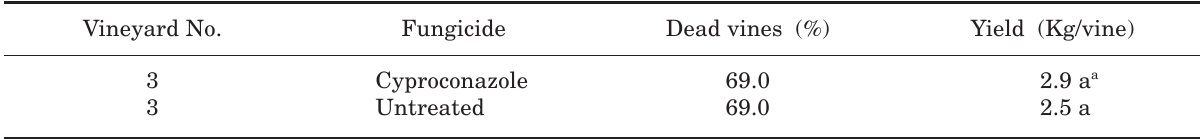
Table 10. Ground application of fungicide by injector pole: percentage of dead plants and yield in 2002. Vineyard No. Fungicide Dead vines